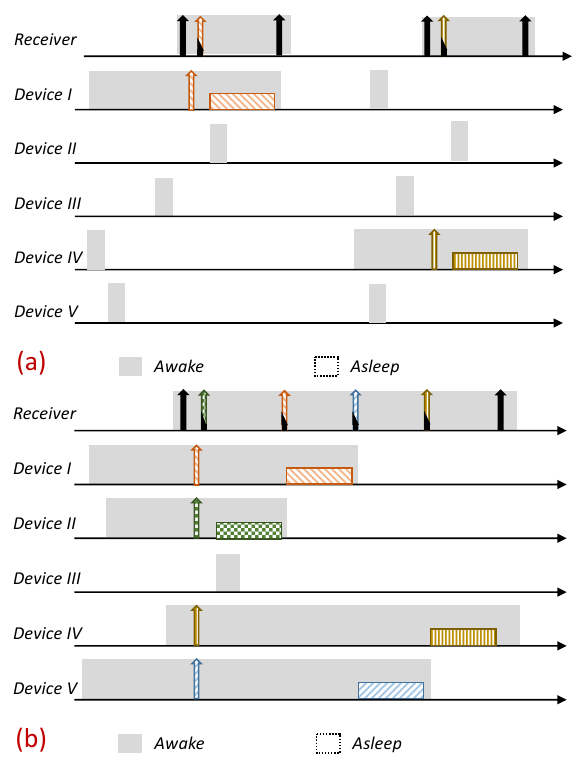
Figure 2. Overview of the Multiple-Access Reservation Receiver Initiation MAC (MAR-RiMAC) protocol. A backlogged device waits silently for its intended receiver beacon to send a reservation transmission. The sink sequentially polls the backlogged devices for transmission. Similarly to RI- MAC, a non-backlogged device wakes up periodically, broadcasts its wakening notification, and, if no device transmits to it, goes back to sleep. ( a ) Under low load. ( b ) Under high load, when multiple devices attempt transmission simultaneously, the sink can identify them and poll them